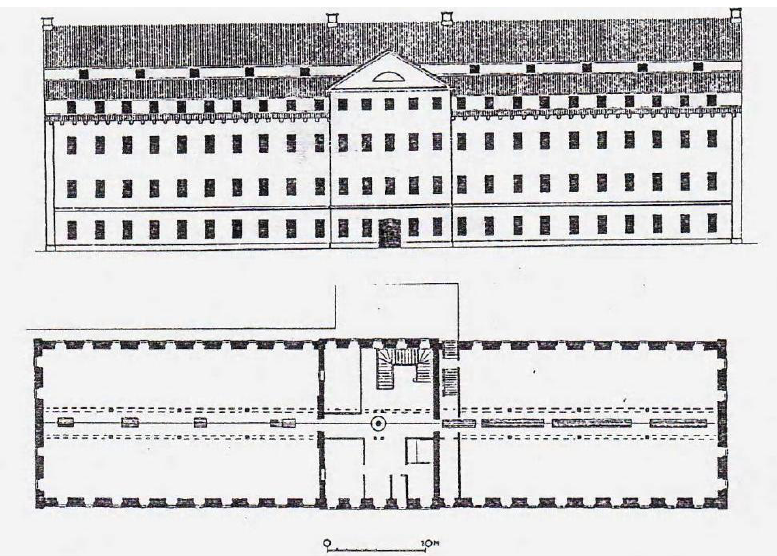
Fig. 5. Wendisch manufacture. Spinning mill in Księży Młyn. Site map copy. AGAD. Collection of maps. 30-4 according to I. Popławska